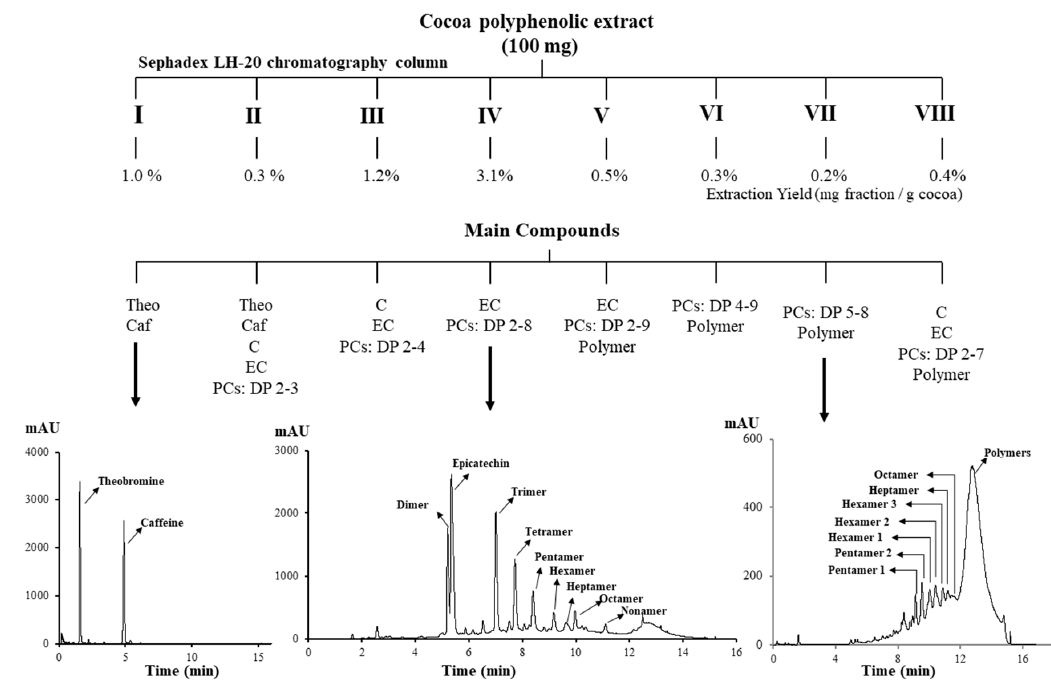
Figure 2. Scheme for the separation of cocoa procyanidins using Sephadex LH-20. Theobromine, Theo; Caffeine, Caf; (+)-Catechin, C; ( – )-Epicatechin, EC; PCs, procyanidins; DP, degree of